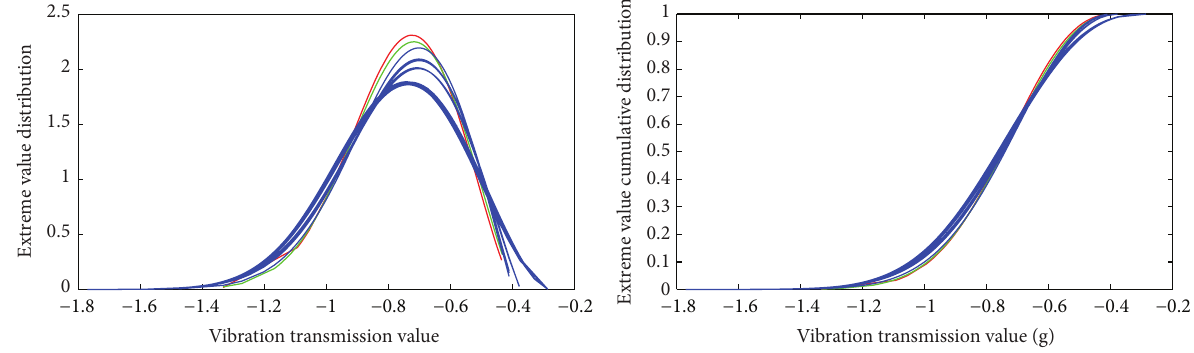
Figure 3: Minimum distribution curves with increasing data amount.